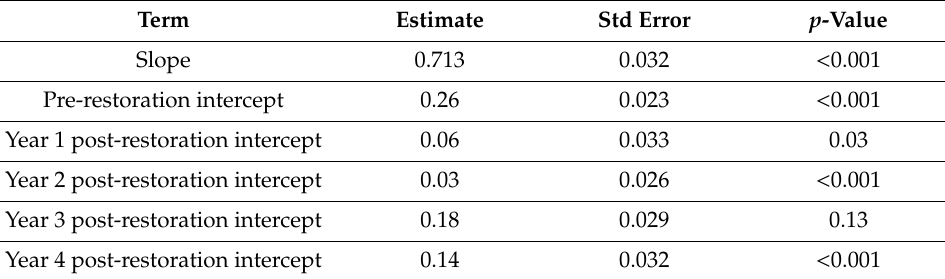
Table 4. Regression coefficients and statistics for depth to groundwater regression models for pre-